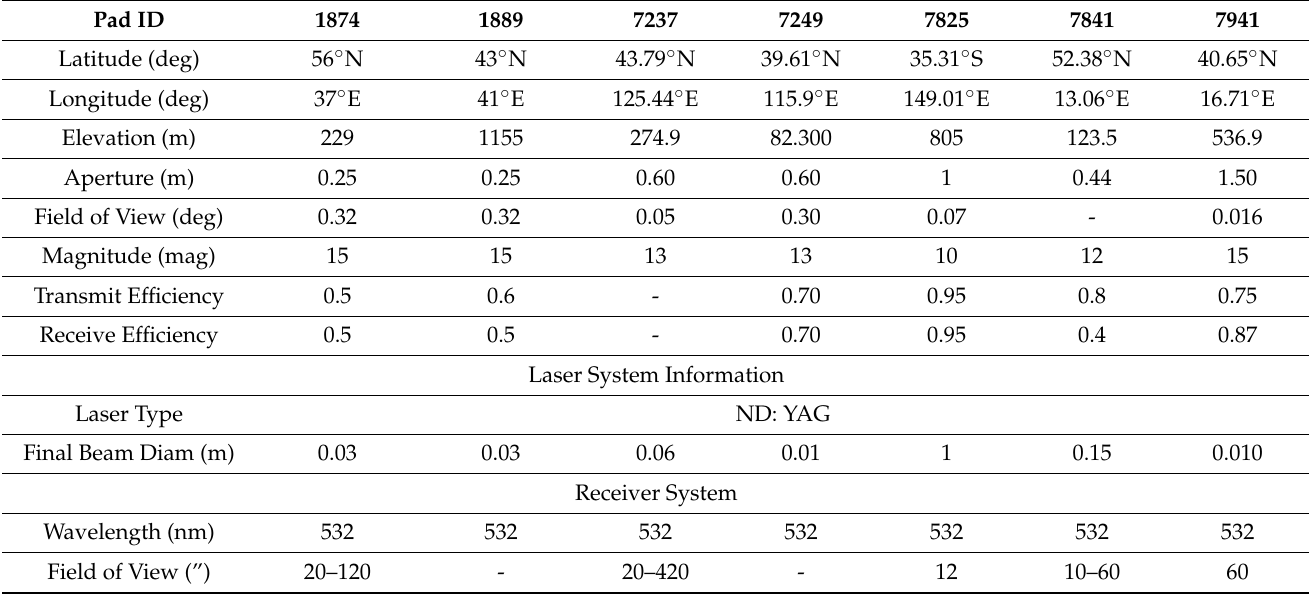
Table 2. Laser satellite tracking stations